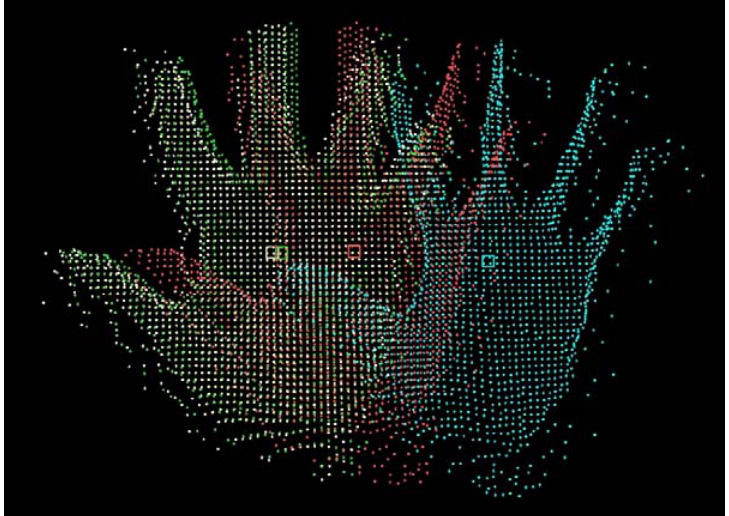
Figure 8. Tracking result: Tracked centroids and corresponding hand